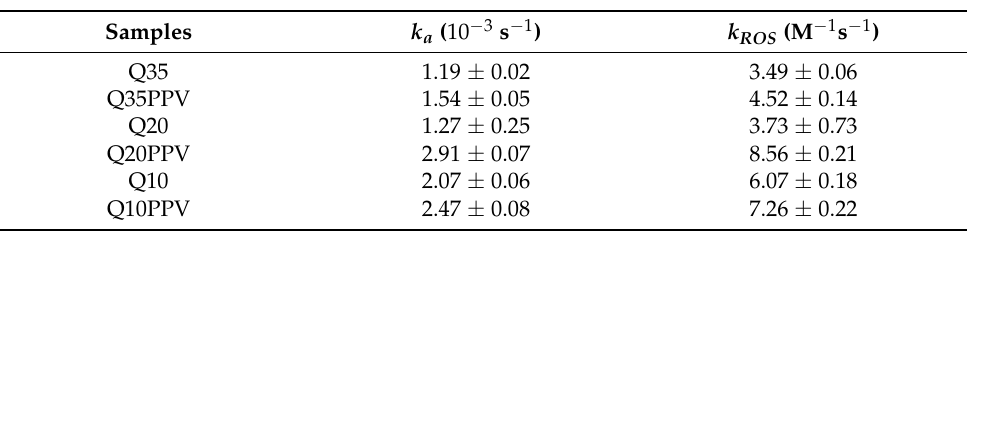
Table 1. Rate constant of ROS production under blue-light irradiation. k a and k ROS values were obtained as presented in Section S.3 in the Supplementary